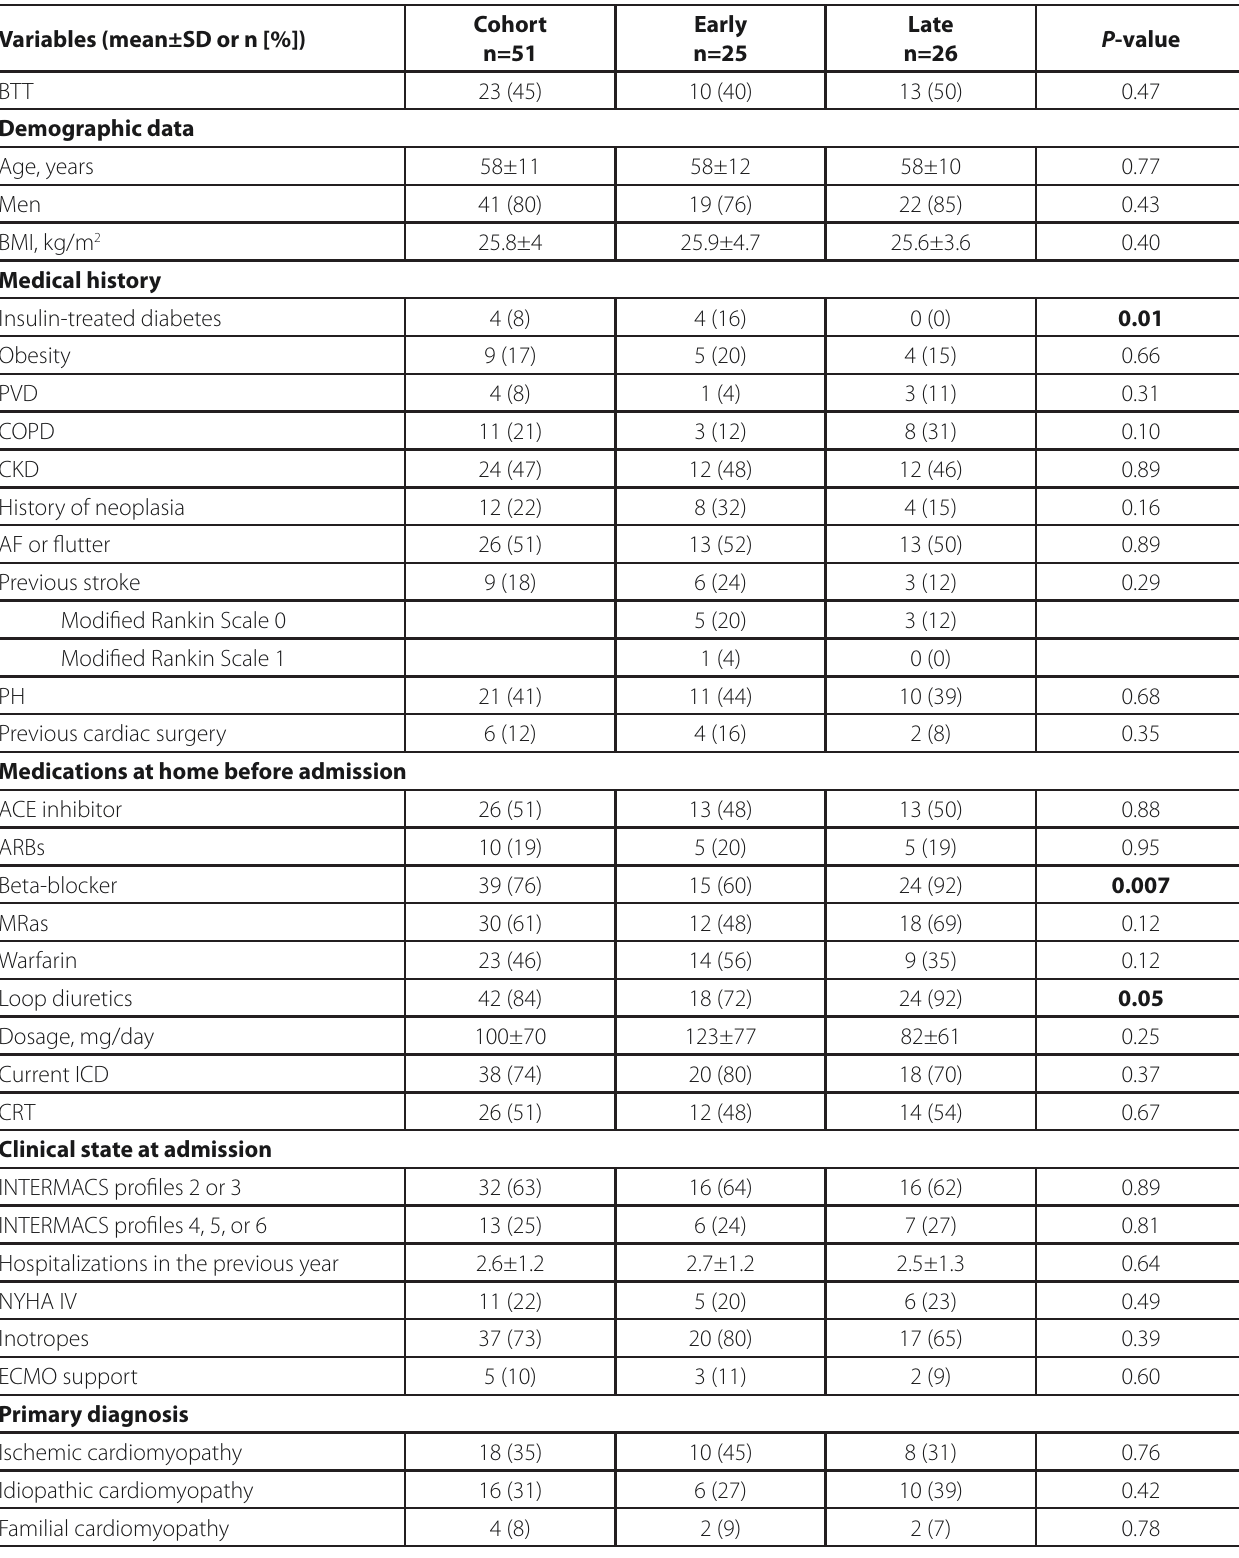
Table 2. Patient characteristics and perioperative data in the early (2009 to 2014) and late (2014 to 2017) eras of HeartMate II